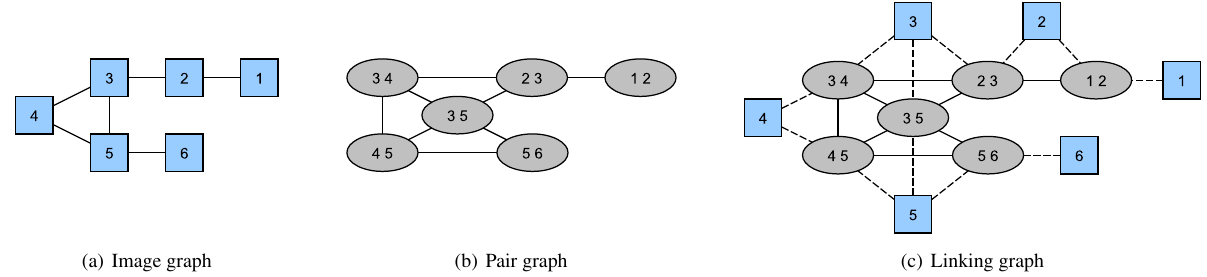
Figure 1. Image graph with corresponding line and linking graph. The line graph of the image graph is the pair graph describing relations between pairs. Adding nodes of the image graph to the pair graph results in the linking graph where rectangles represent the image and ellipses the pair